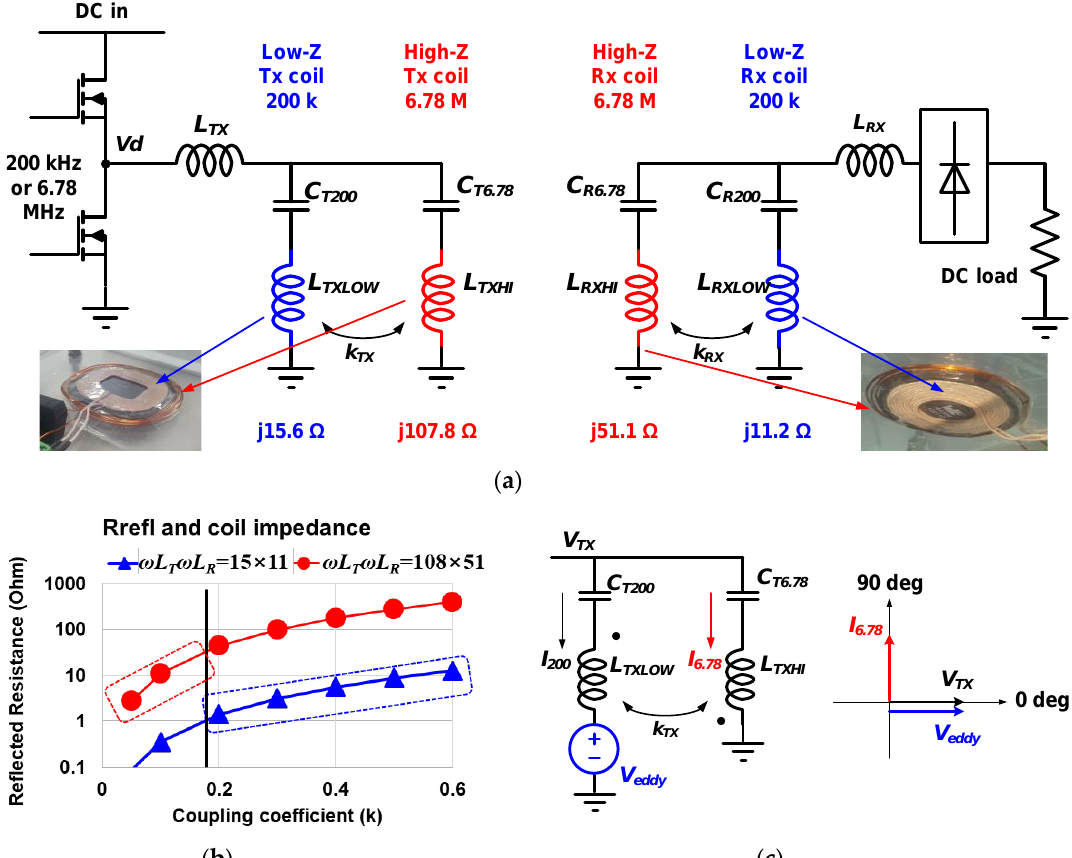
Figure 3. ( a ) Proposed dual-impedance operation by dual-frequency capability. For low-coupling condition, high-impedance coil paths are activated by 6.78 MHz operation. For high-coupling, low-impedance coil paths are activated. This can suppress excessive variations of reflected resistance which would serve as load resistor of Tx inverter, thus stabilizing the inverter efficiency. ( b ) The coil impedances are designed such that the reflected resistance is bounded within 1–30 Ω across the whole coupling coefficient k range. ( c ) Eddy current at L T(R)XLOW during 6.78 MHz mode is prevented by adjusting the magnitude and phase of I 6.78 , so that V eddy and V TX are the same and the voltage across Low-Z path is zero [20].